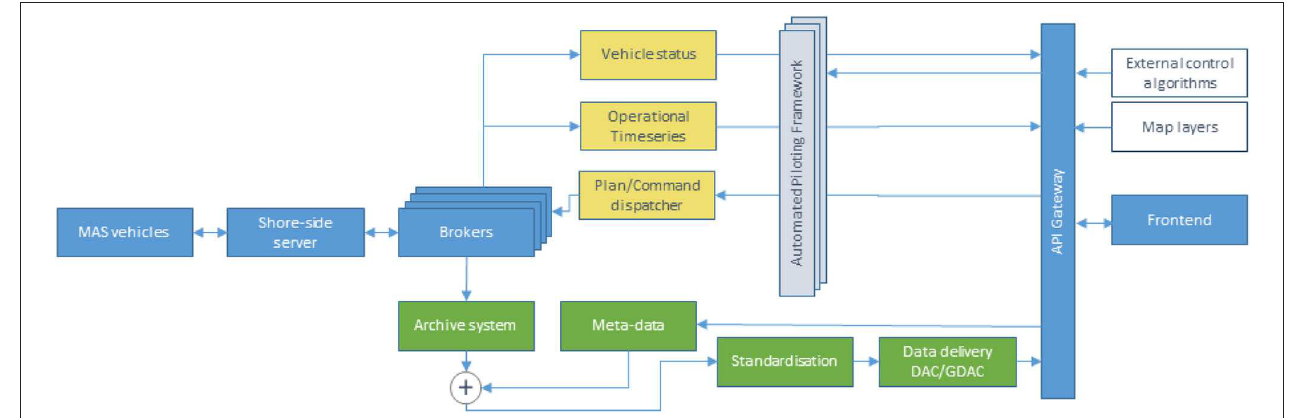
FIGURE 4 | Workflow of the C2 system, from MAS vehicles to the Frontend user-interface. Piloting pathway components are highlighted in yellow, data pathway in